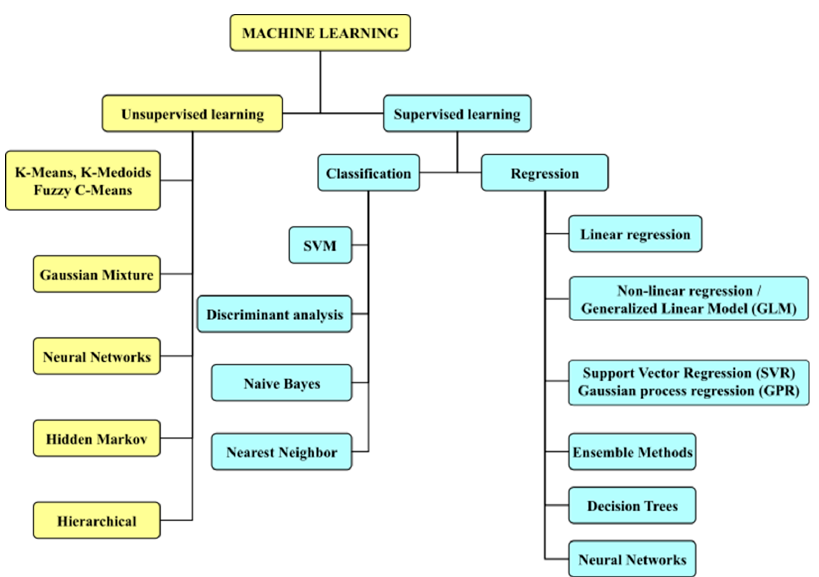
Figure 12. Optimization models. “Source [142,157–163], own elaboration.”.